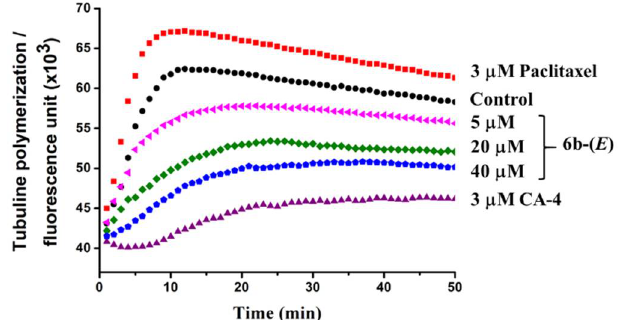
Figure 6. Effects of 6b-(E) on tubulin polymerization in vitro. Tubulin (10 mg/mL) was incubated with 6g-(E) (5, 20 and 40 μM) for 50 min at 37 °C. Paclitaxel (3 μM) and CA-4 (3 μM) were used as positive controls. The fluorescence intensity was monitored every minute for characterization of tubulin polymerization at a 360 nm excitation wavelength and 460 nm emission wavelength.